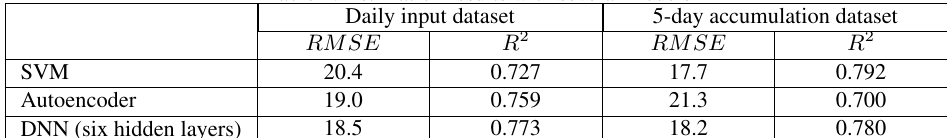
Table 2: Estimation results with several models Daily input dataset